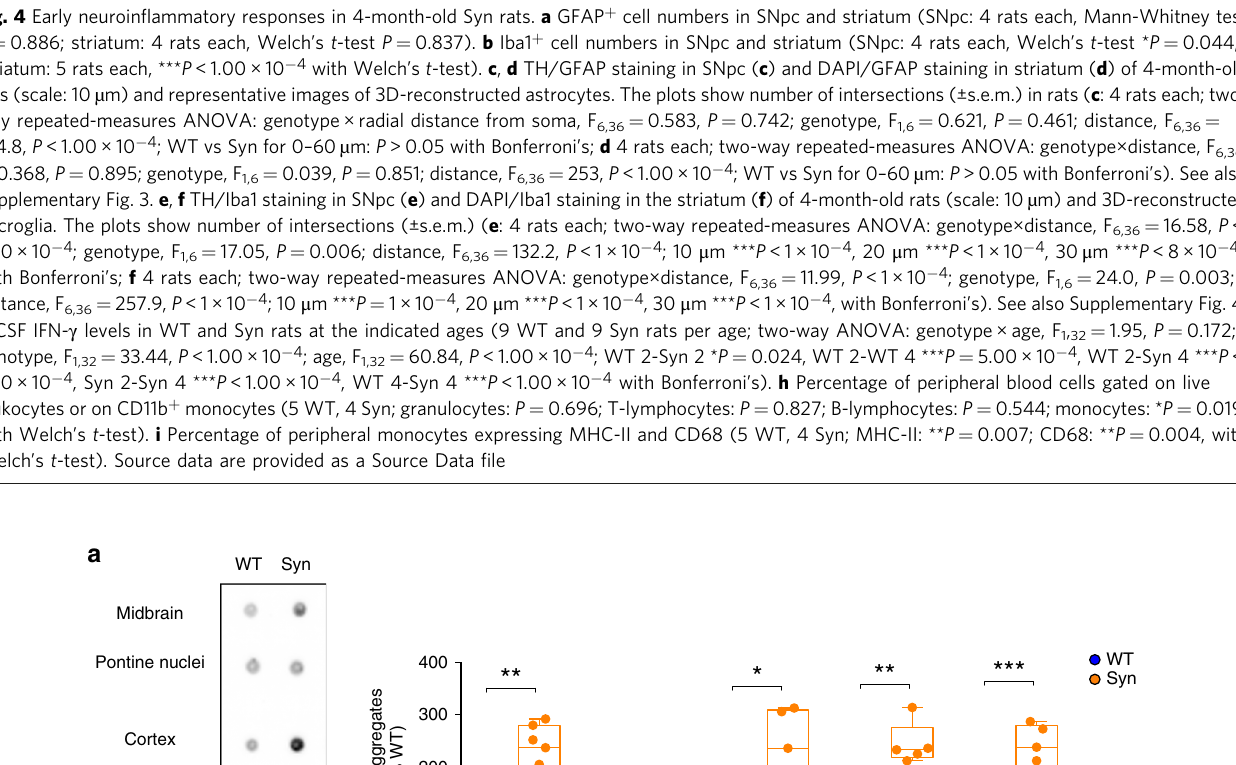
Fig. 4 Early neuroin fl ammatory responses in 4-month-old Syn rats. a GFAP + cell numbers in SNpc and striatum (SNpc: 4 rats each, Mann-Whitney test P = 0.886; striatum: 4 rats each, Welch ’ s t -test P = 0.837). b Iba1 + cell numbers in SNpc and striatum (SNpc: 4 rats each, Welch ’ s t -test * P = 0.044; striatum: 5 rats each, *** P < 1.00 × 10 − 4 with Welch ’ s t -test). c , d TH/GFAP staining in SNpc ( c ) and DAPI/GFAP staining in striatum ( d ) of 4-month-old rats (scale: 10 µ m) and representative images of 3D-reconstructed astrocytes. The plots show number of intersections (±s.e.m.) in rats ( c : 4 rats each; two- way repeated-measures ANOVA: genotype× radial distance from soma, F 6,36 = 0.583, P = 0.742; genotype, F 1,6 = 0.621, P = 0.461; distance, F 6,36 = 194.8, P < 1.00 × 10 − 4 ; WT vs Syn for 0 – 60 µ m: P > 0.05 with Bonferroni ’ s; d 4 rats each; two-way repeated-measures ANOVA: genotype×distance, F 6,36 = 0.368, P = 0.895; genotype, F = 0.039, P = 0.851; distance, F = 253, P < 1.00 × 10 − 4 ; WT vs Syn for 0 – 60 µ m: P > 0.05 with Bonferroni ’ s). See also 1,6 6,36 Supplementary Fig. 3. e , f TH/Iba1 staining in SNpc ( e ) and DAPI/Iba1 staining in the striatum ( f ) of 4-month-old rats (scale: 10 µ m) and 3D-reconstructed microglia. The plots show number of intersections (±s.e.m.) ( e : 4 rats each; two-way repeated-measures ANOVA: genotype×distance, F 6,36 = 16.58, P < 1.00 × 10 − 4 ; genotype, F 1,6 = 17.05, P = 0.006; distance, F 6,36 = 132.2, P < 1 × 10 − 4 ; 10 μ m *** P < 1 × 10 − 4 , 20 μ m *** P < 1 × 10 − 4 , 30 μ m *** P < 8 × 10 − 4 , with Bonferroni ’ s; f 4 rats each; two-way repeated-measures ANOVA: genotype×distance, F 6,36 = 11.99, P < 1 × 10 − 4 ; genotype, F 1,6 = 24.0, P = 0.003; distance, F 6,36 = 257.9, P < 1 × 10 − 4 ; 10 μ m *** P = 1 × 10 − 4 , 20 μ m *** P < 1 × 10 − 4 , 30 μ m *** P < 1 × 10 − 4 , with Bonferroni ’ s). See also Supplementary Fig. 4.